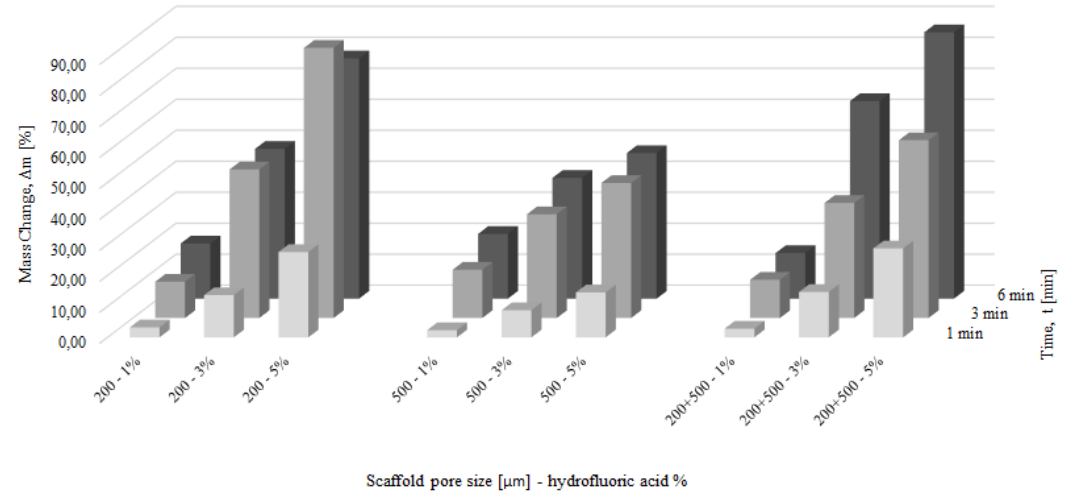
Figure 4. Mass change of scaffolds after hydrofluoric acid baths for 1, 3 and 6 min.